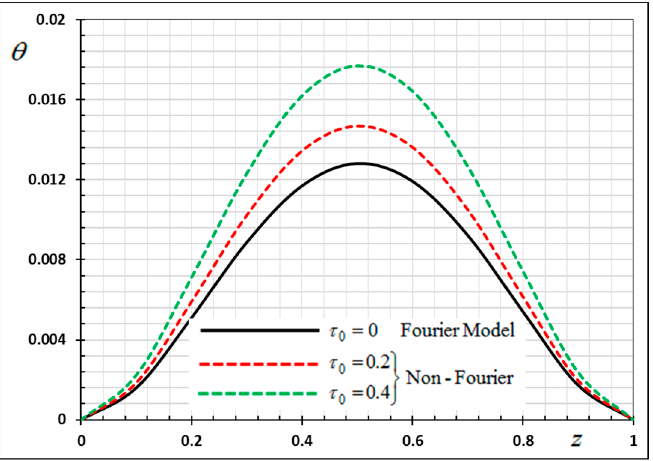
Figure 17. Variation of temperature θ versus z for Fourier and non-Fourier models.